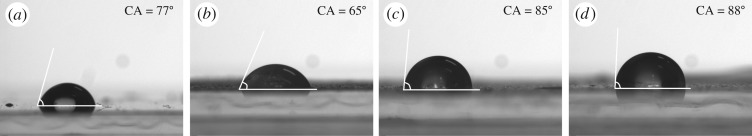
Water CA of different membranes (a) Pristine PEBA membrane, (b) 5% MCM-41-PEBA membrane, (c) 5% MCM-41-IL1-PEBA membrane and (d) 5% MCM-41-IL2-PEBA membrane.